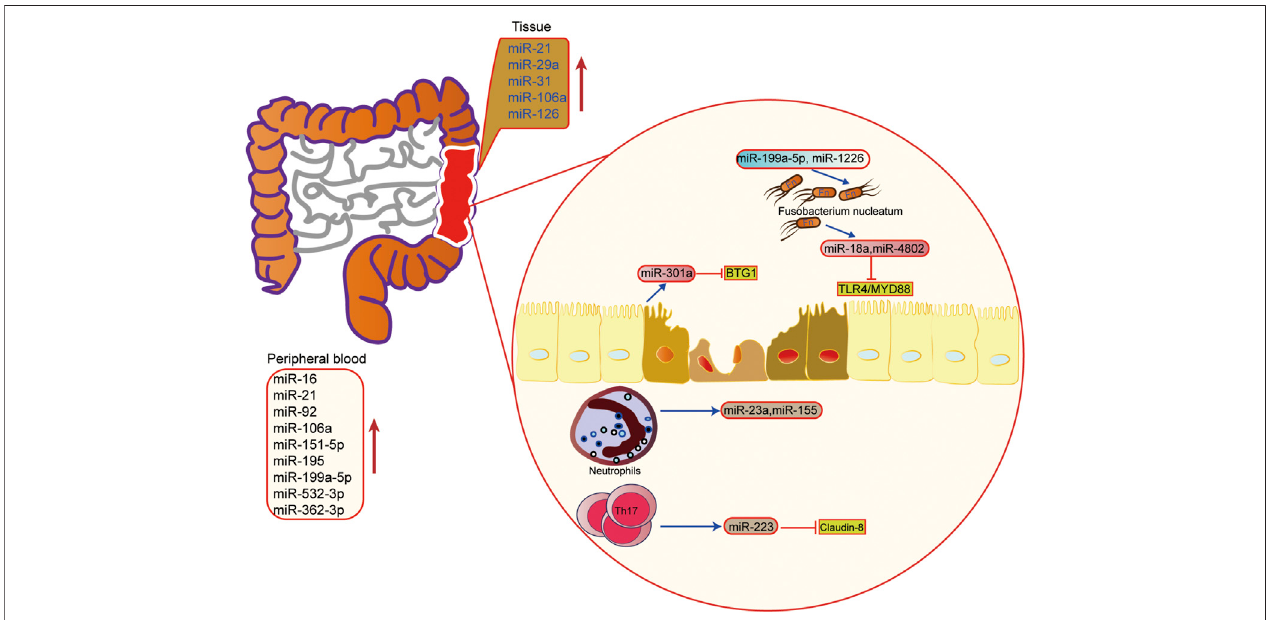
FIGURE 4 | The role of microRNAs in epigenetic regulation in in fl ammatory bowel disease. The upregulated microRNA in in fl ammatory bowel disease tissue and peripheral blood. miRNA also mediated the interaction of microbiota microbiome, immune cells and host cells in IBD.